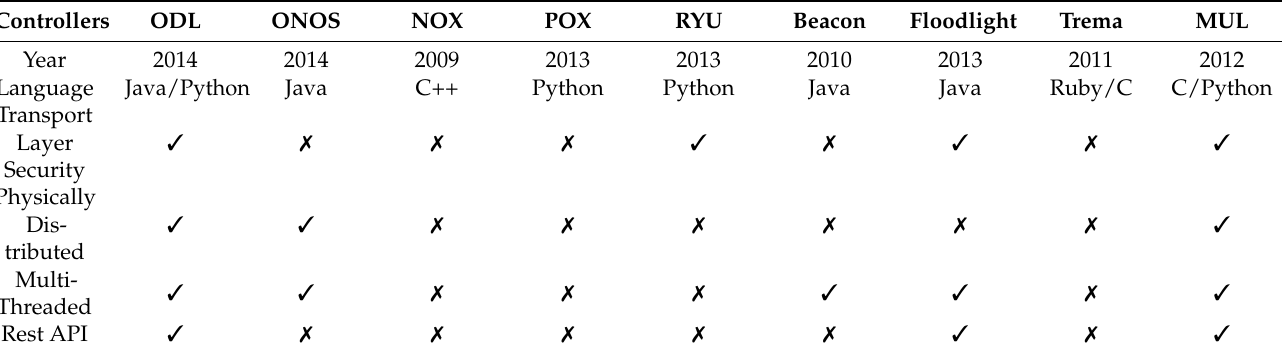
Table 7. Controllers with TLS, PD, MT, and